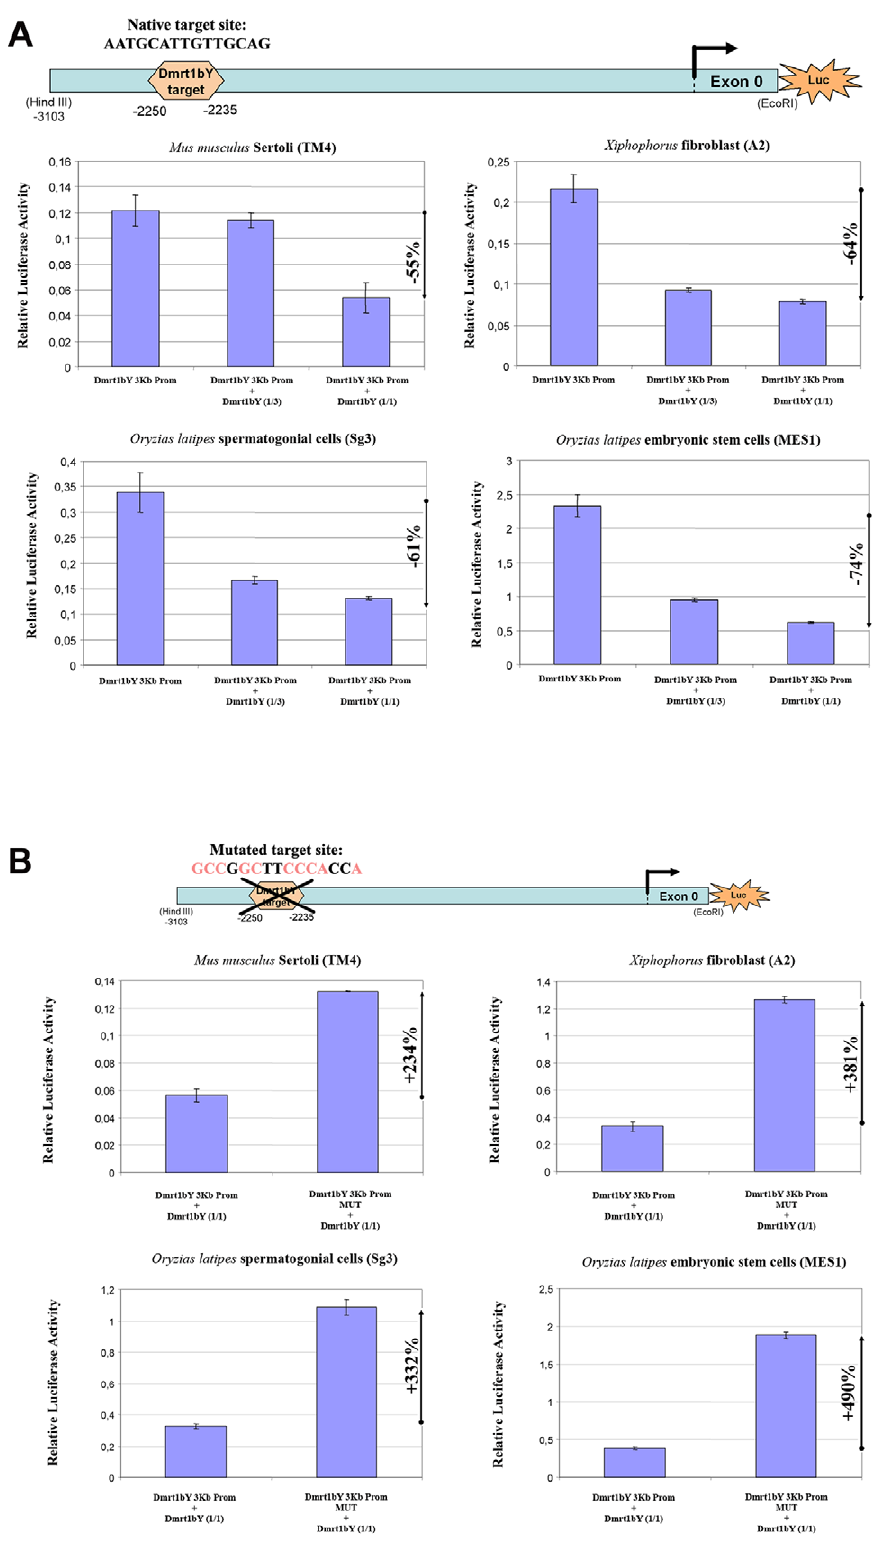
Figure 2. Transient-transfection analysis. (A) Transient-transfection analysis of proximal dmrt1bY promoter activity co-transfected in different ratios of a dmrt1bY expressing plasmid. The 3 Kb proximal dmrt1bY promoter construct was co-transfected with different amounts of dmrt1bY - expressing plasmid (1:3 and 1:1 ratios) in different cell lines. (B) Transient-transfection analysis of mutant proximal dmrt1bY promoter activity. In all the cell lines, when overexpressing Dmrt1bY, the 3 Kb mutant proximal dmrt1bY promoter construct (lacking the Dmrt1 binding site) shows higher activity compared to the ‘‘wild-type’’ construct containing the Dmrt1 target site. The data are presented as the firefly/Gaussia luciferase activity. Transfections were done three times; error bars represent the standard errors of the means.